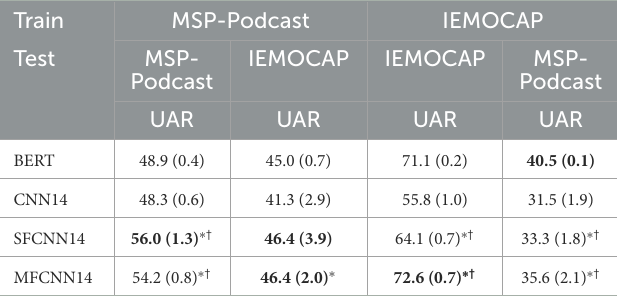
TABLE 1 UAR(%) in- and cross-domain results for 4-class emotion recognition (chance level: 25 % ). Train MSP-Podcast IEMOCAP Test MSP-